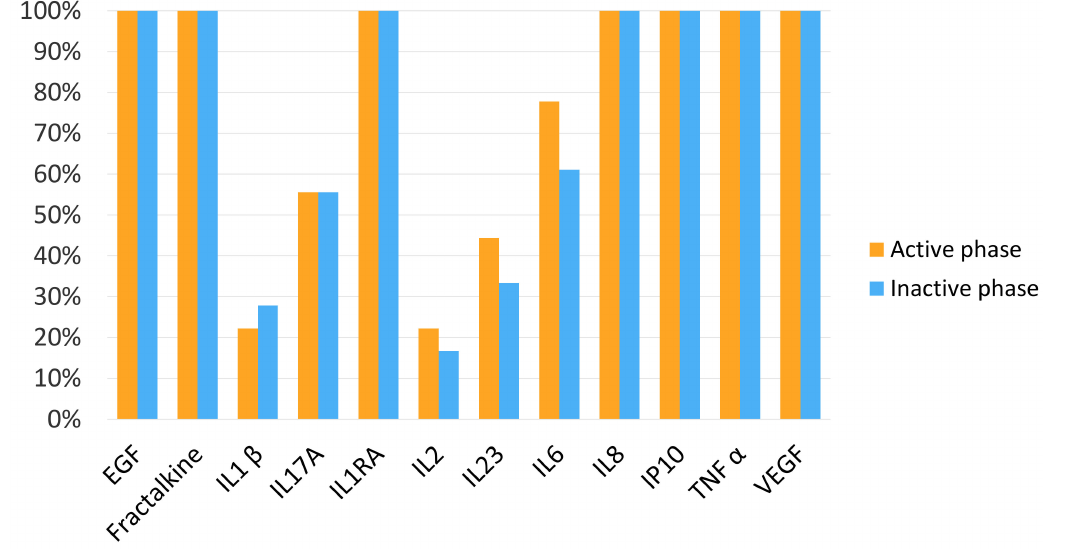
Figure 2. Percentage of epidermal growth factor (EGF), fractalkine, interleukin (IL) 1 receptor antagonist (IL-1RA), IL-1 β , IL-17A, IL-2, IL-23, IL-6, IL-8/CXCL8, interferon-inducible protein (IP)- 10/CXCL10, vascular endothelial growth factor (VEGF) and tumour necrosis factor-alpha (TNF- α ) detection in plasma in the active phase and inactive